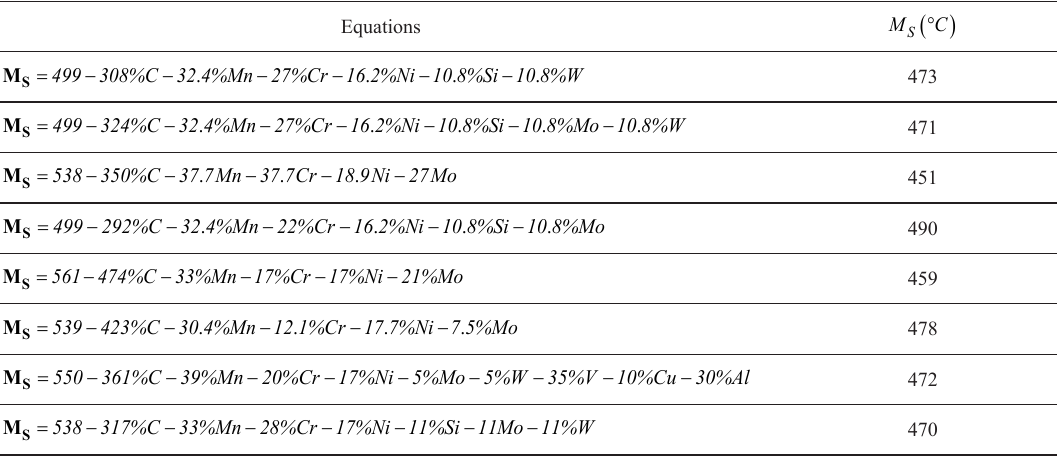
Table 3. Martensite start temperature calculated for the studied steel applying empirical equations available in the literature 27 .